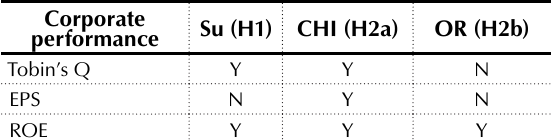
Table 4. Results